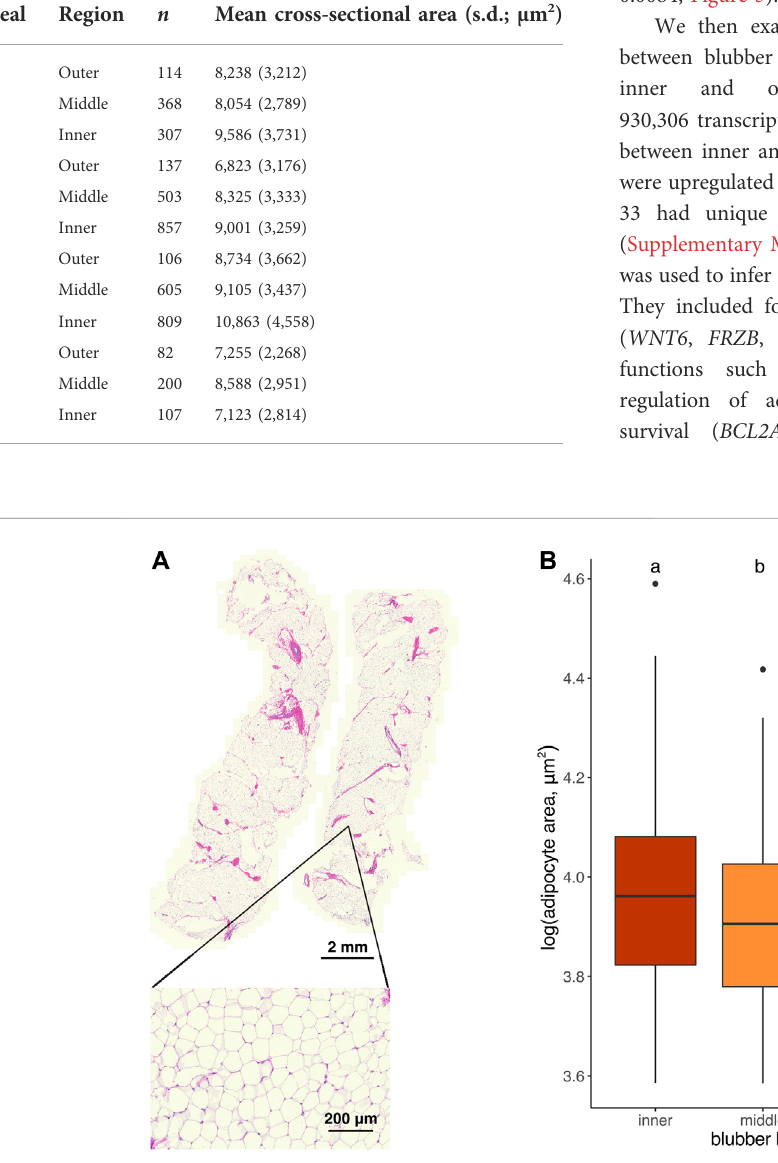
FIGURE 2 (A) Longitudinally-sectioned elephant seal blubber sample stained with hematoxylin and eosin. Inset shows an example region of interest (ROI) within which adipocyte areas were measured. (B) Cross-sectional area of adipocytes in outer, middle, and inner blubber regions of four juvenile elephant seals. Different letters denote values that were signi fi cantly different ( p < 0.05) between blubber